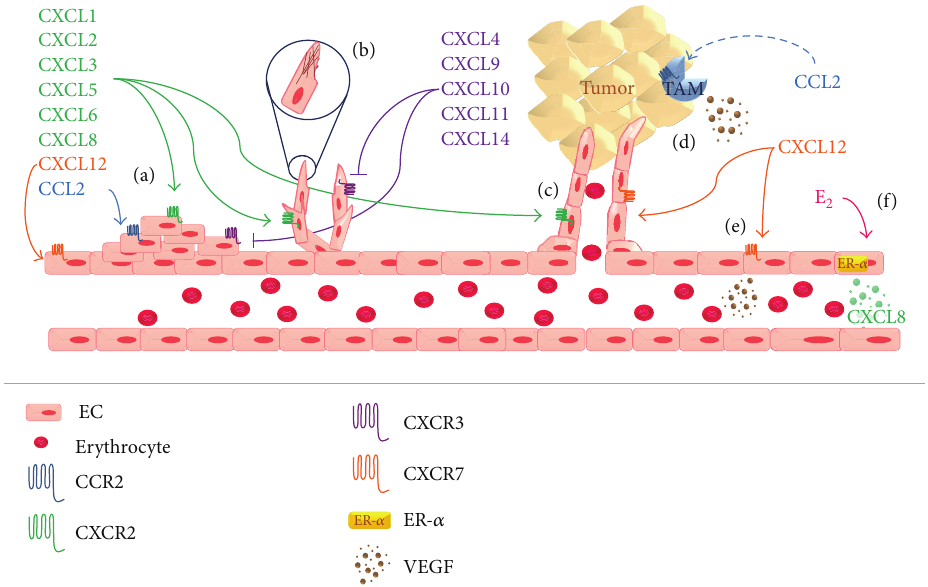
Figure 2: Chemokines involvement in angiogenesis. Angiogenic ELR + chemokines act through CXCR2 receptor to promote (a) proliferation of endothelial cells (EC), (b) stress fibre assembly, and (c) tube formation. On its behalf, antiangiogenic non-ELR + chemokines, via CXCR3, inhibit these processes. CCL2 also promotes angiogenesis via CCR2, (a) stimulating EC proliferation and (d) in an indirect manner by increasing TAM infiltration, which secrete angiogenic factors like VEGF. CXCL12 acts through CXCR7 to promote (a) EC proliferation and (e) VEGF production by these cells. It has been reported that (f) estrogen (E 2 ) stimulates EC secretion of CXCL8.